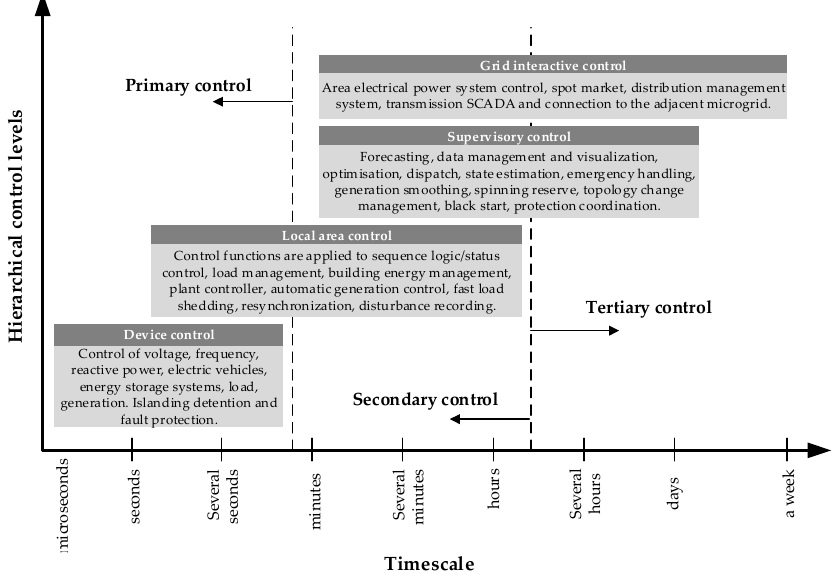
Figure 1. Hierarchical control levels to microgrid management categorised based on the timescale at which it is acting.